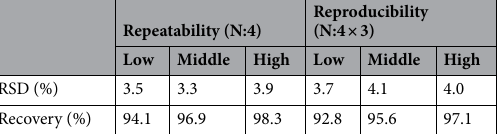
Table 6. Repeatability and reproducibility studies for the precision of the application